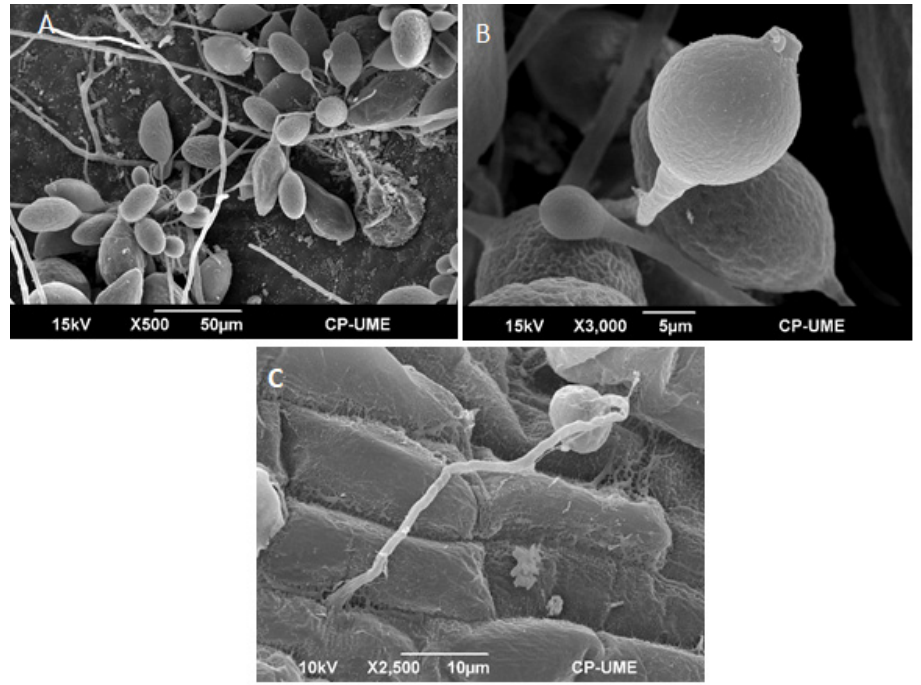
Figure 4. Phytophthora capsici on seed root tissue of S. edule var. virens levis Costa Rica Type. ( A , B ) sporangia and zoospores. ( C ) in germinated seed root tissue. Scanning electron microscope micrographs. 500×, 3000×, 2500×, respectively.